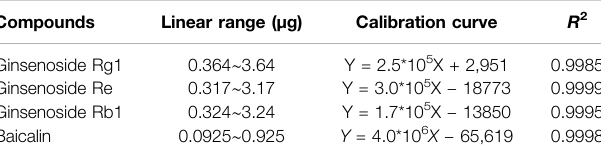
TABLE 1| Linear range, R 2 , andlimits ofquanti fi cation ofcalibration curve used to determine the main identi fi ed compounds.